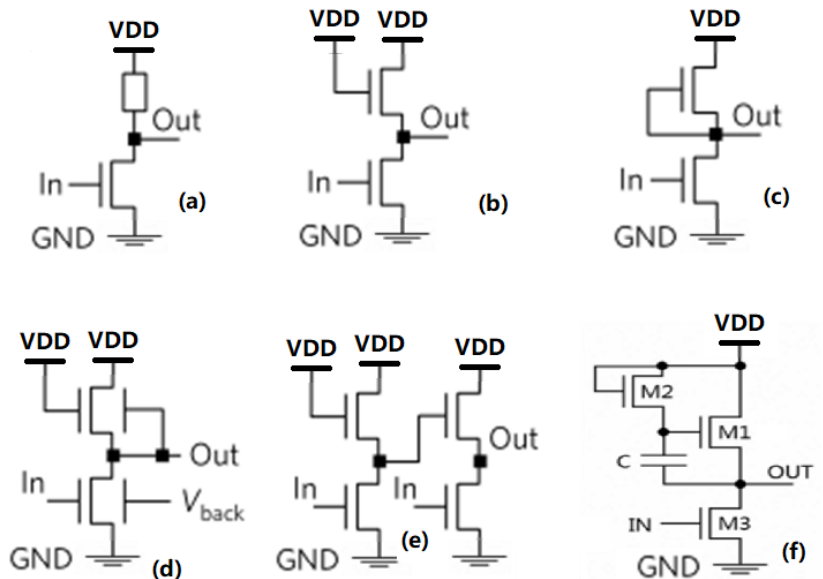
Figure 11. ( a ) Resistive-load logic inverter, ( b ) Diode-load logic inverter, ( c ) Zero-V gs -load logic inverter, ( d ) Dual-gate n-type diode-load logic inverter, ( e ) n-type diode-load pseudo-CMOS logic inverter, and ( f ) Bootstrapped NOT logic inverter.